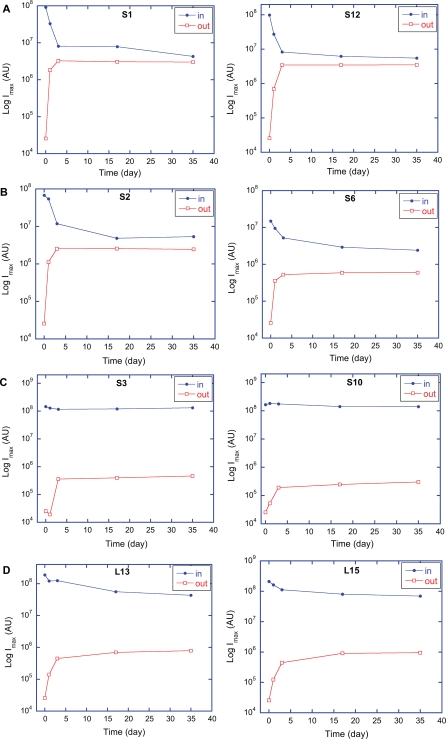
Monomer Release Profiles of GnRH Analogs from AggregatesTime-dependent monomer release was measured by the intrinsic fluorescence of the GnRH analogs with excitation at 280 nm and emission at the range of 290–500 nm. The volume- and concentration-corrected fluorescence maxima (I
max) from both inside (in) and outside (out) of the membrane medium were plotted against time of incubation. The fluorescence intensity is expressed in arbitrary units (AU). A representative set of profiles are shown: in (A), the monomer release of the short-acting analogs S1 and S12, which do not form fibrils; in (B), the monomer release of short-acting analogs S2 and S6, which form unstable fibrils; in (C), the monomer release of short-acting analogs S3 and S10, which form very stable fibrils; and in (D), the monomer release of the long-acting analogs L13 and L15.